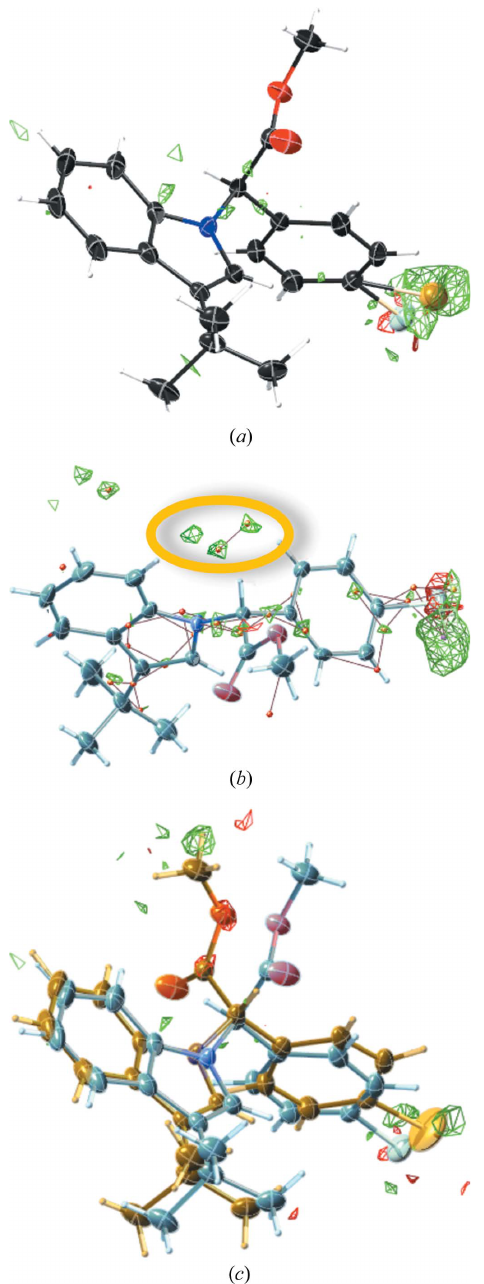
Figure 2 Displacement ellipsoid representations of methyl (4-bromophenyl)(3- tert -butyl-1 H -indol-1-yl)acetate, CSD refcode CAWWIJ, generated with SHELXLE (Hu¨bschle et al. , 2011). ( a ) The result of the original deposition, with residual-electron-density meshes (0.3 e A˚ (cid:3) 3 throughout) in green. ( b ) The outcome of a restrained (DFIX/DANG) refinement of the major component only, while ( c ) shows the result of a final restrained and additionally constrained (EADP) refinement. For ( b ), additional (highlighted) residual-density peaks for the disordered atoms from the second molecular orientation Birger Dittrich (cid:2) Modelling disordered crystal structures and distinguishing disorder